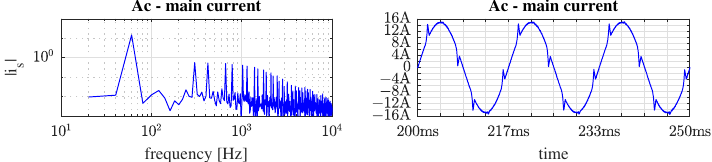
Figure 17. Ac-main current (compensated current): FFT results and waveform.